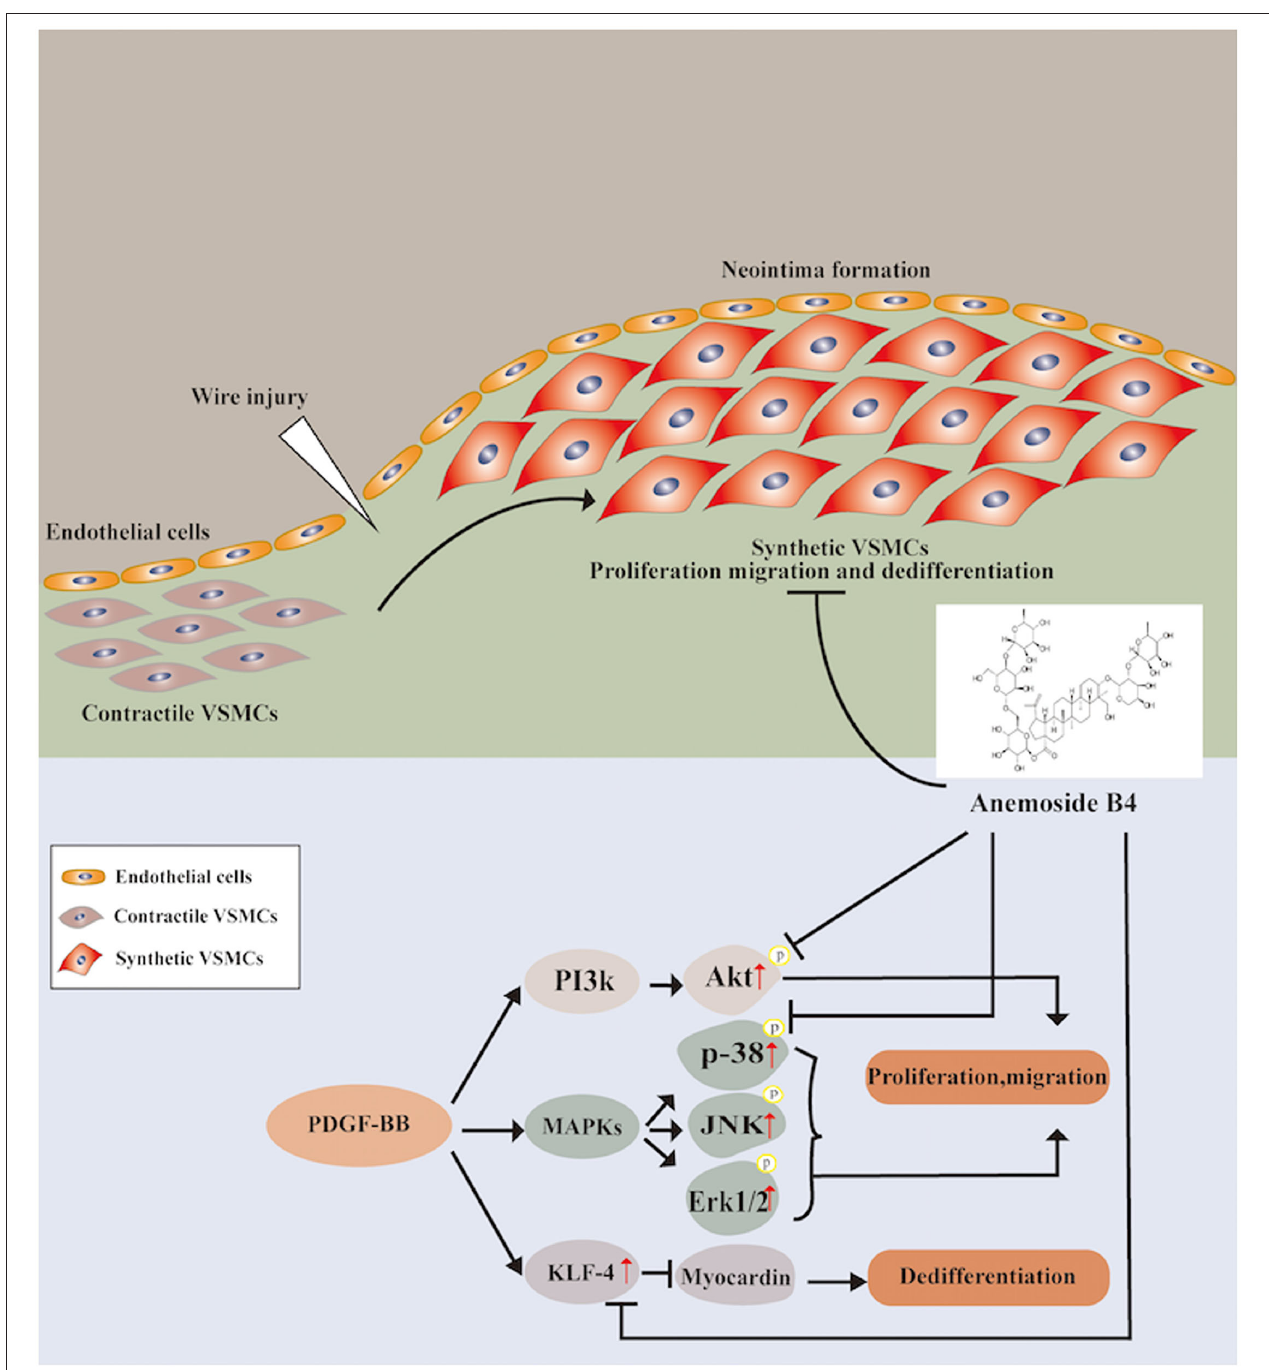
FIGURE 7 | Schematic diagram of the potential mechanisms of B4 in regulating PDGF-BB-induced VSMC proliferation, migration, and dedifferentiation.